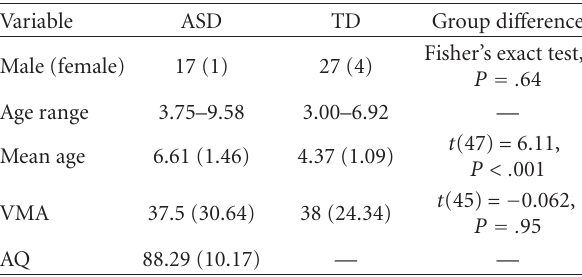
Table 1: Participant characteristics in each group.